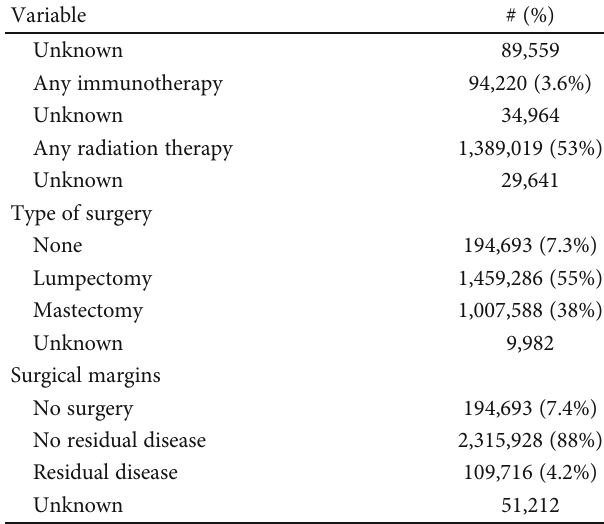
Table 2: Clinical characteristics of breast cancer patients diagnosed between 2004 and